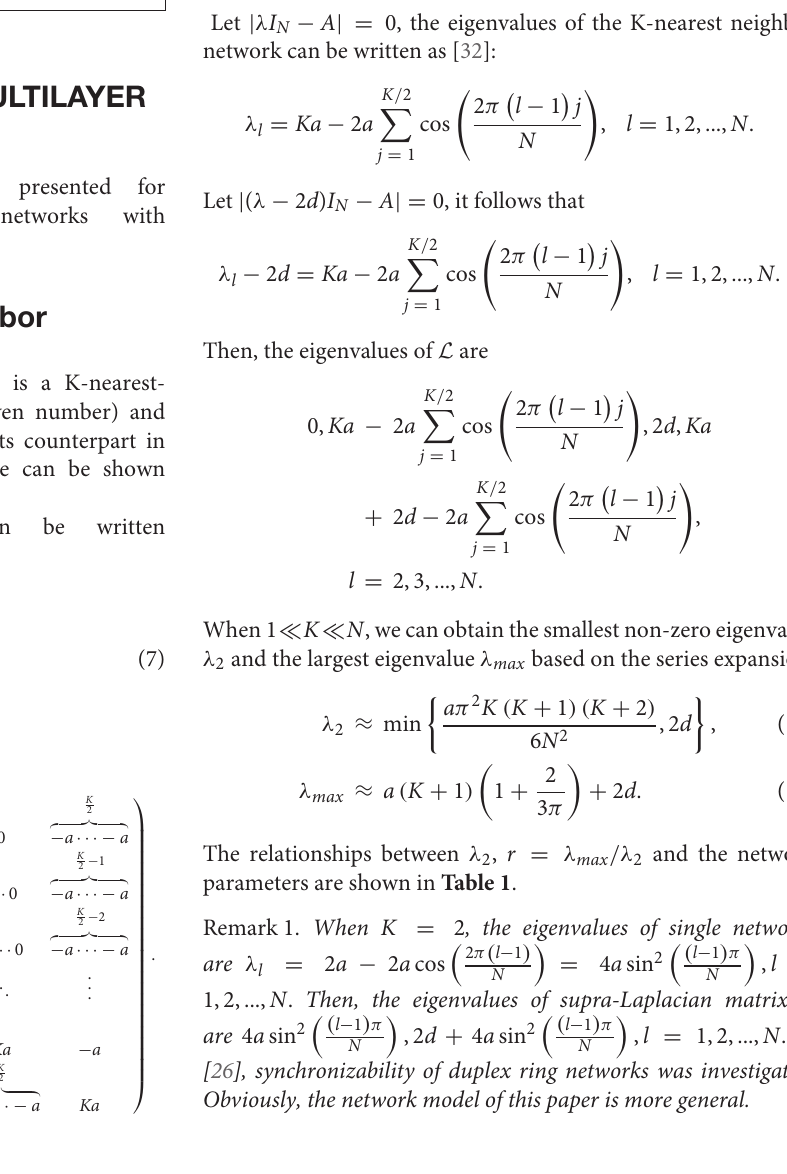
FIGURE 1 | Two-layer networks with K-nearest-neighbor topologies, where d is the inter-layer coupling strength and a is the intra-layer coupling strength.